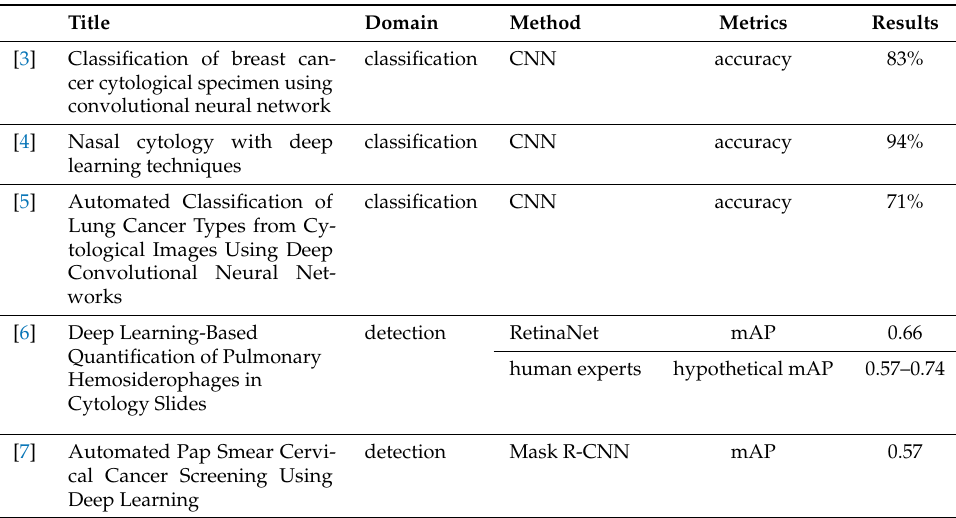
Table 1. The summary of state-of-the-art in machine learning for cytological image